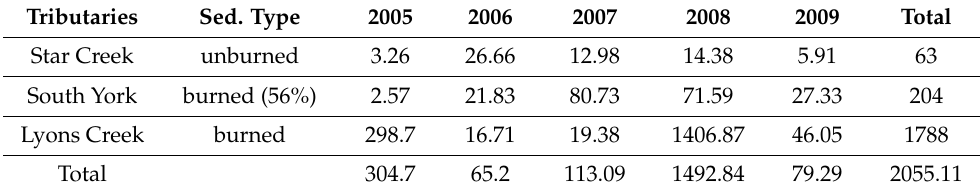
Table 6. Suspended sediment export (metric tonnes per year) from three Crowsnest River tributaries. Tributaries Sed. Type